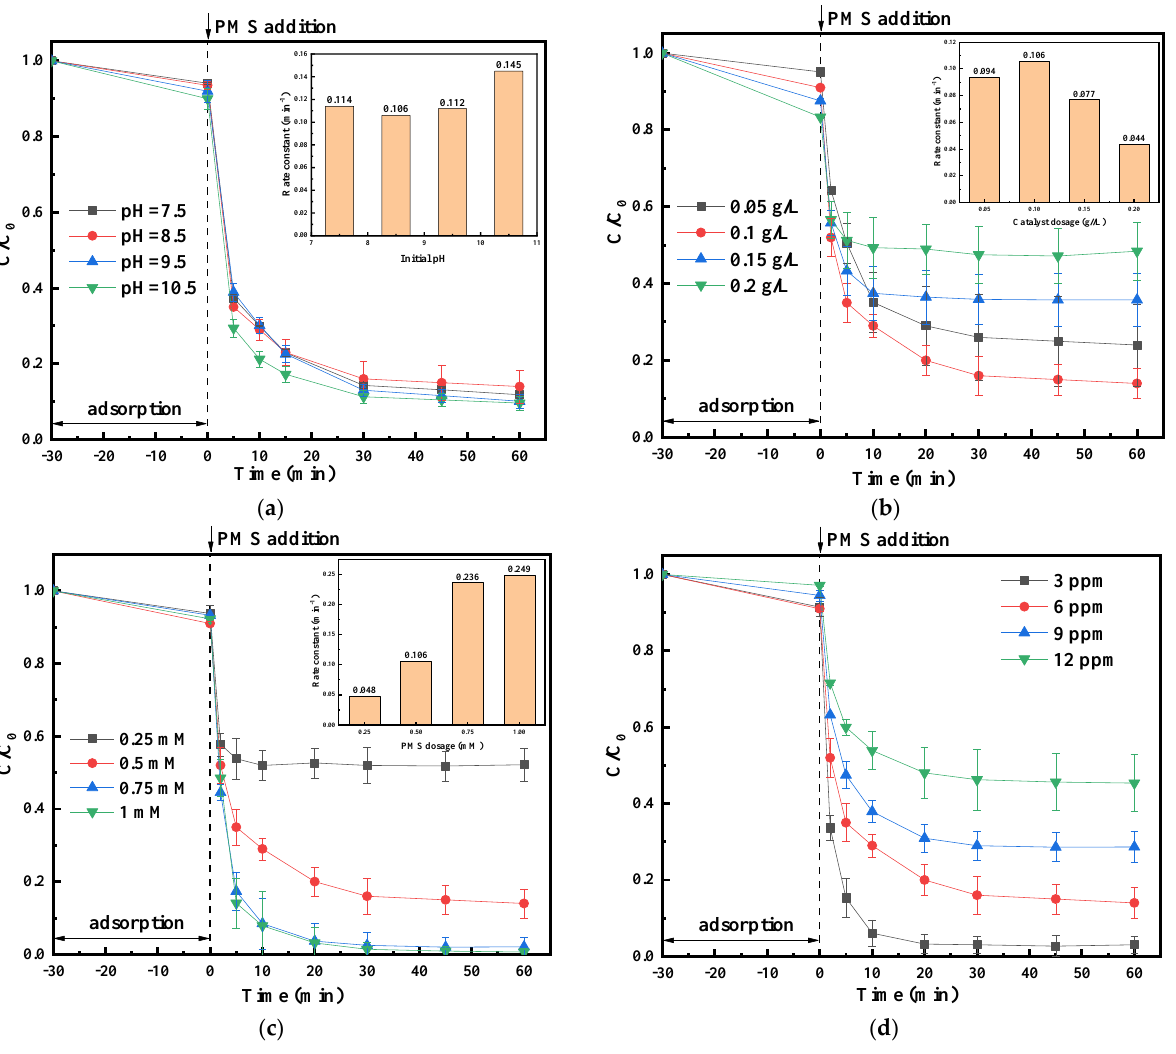
Figure 7. Effects of different initial pH ( a ), catalyst dosage ( b ), PMS dosage ( c ) and DMP concen- tration ( d ) on the DMP removal efficiency. Reaction conditions: initial solution pH = 8.5 (for b – d ); catalyst = 0.1 g/L (for a , c , d ); PMS = 0.5 mM (for a , b , d ); DMP = 6 ppm (for a – c